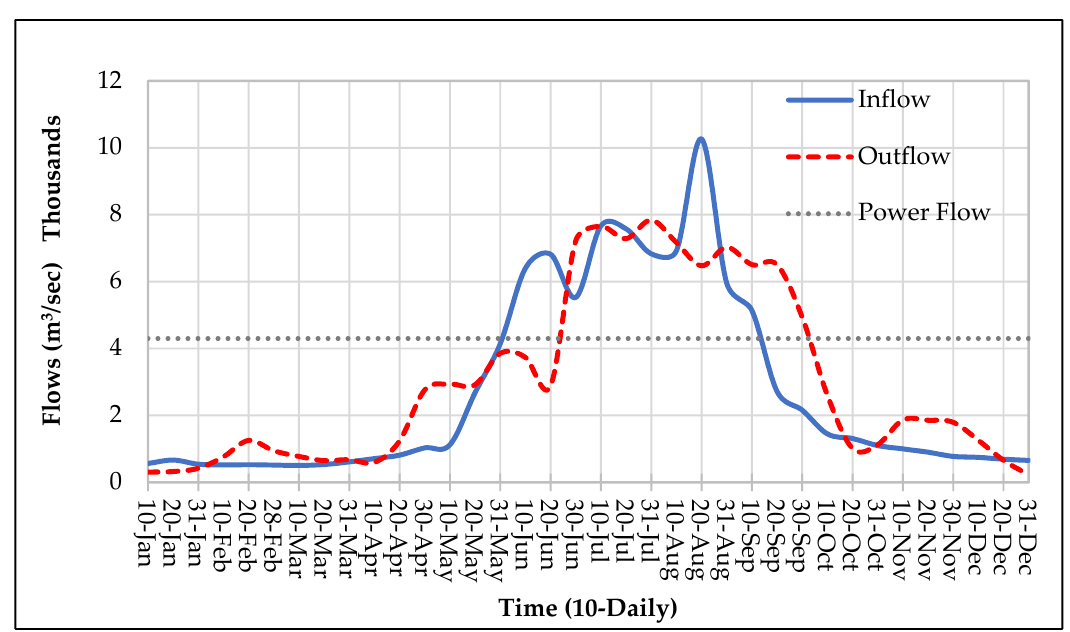
30 of 42 Figure 31. Inflow-Outflow Hydrograph of year 2013.